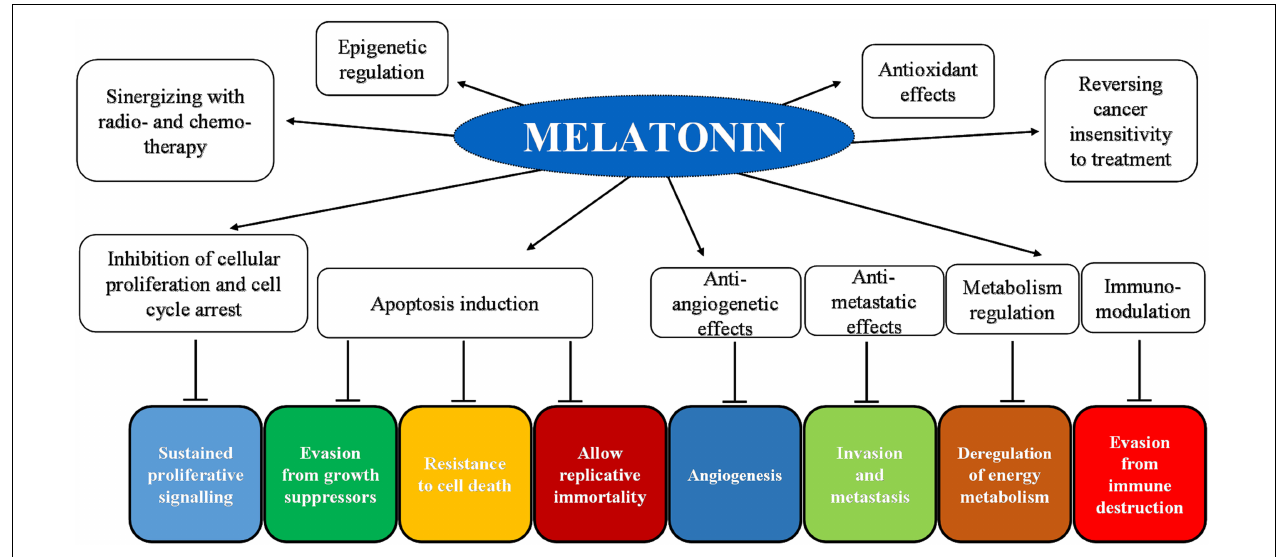
FIGURE 3 | Schematic representation of melatonin’s inhibition of cancer hallmarks with an indication of the main target molecules and the corresponding